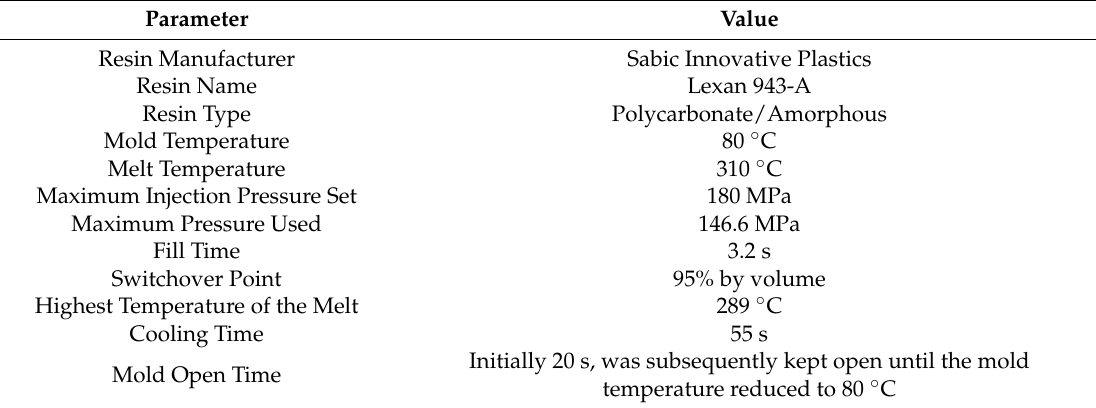
Table 2. Process parameters recommended vs used, for case study 1.